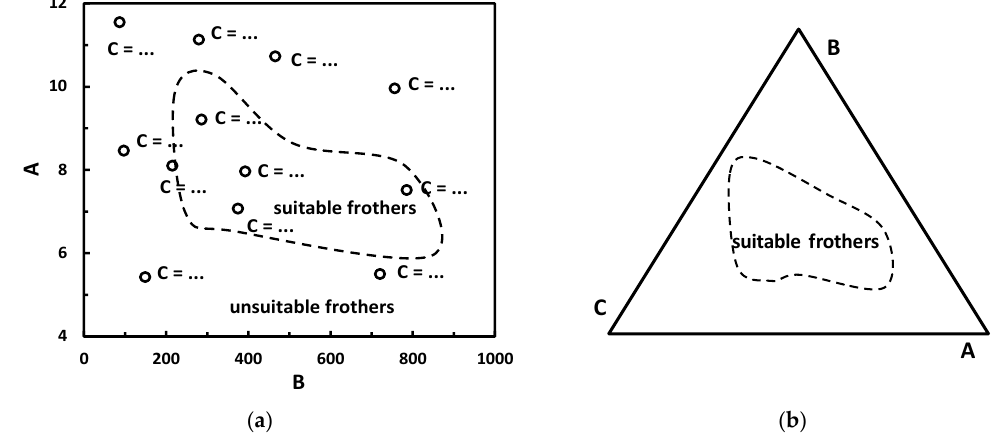
Figure 18. Possible three-numerical value classification of frothers. ( a ) Cartesian x-y plot; ( b ) the Gibbs triangle plot.